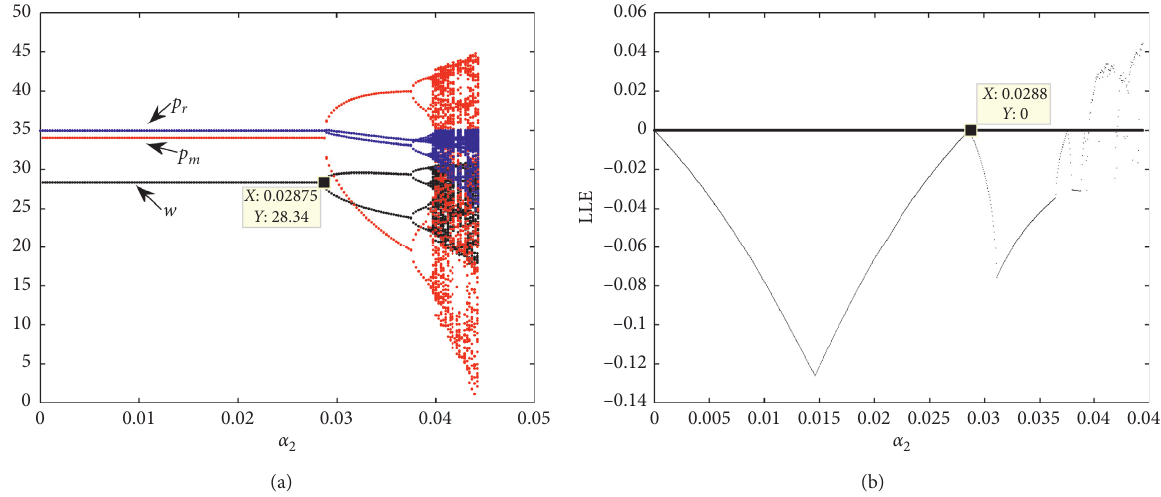
Figure 3: Bifurcation diagram and LLE of the system (17) with varying α � 0 . 2. when λ 2